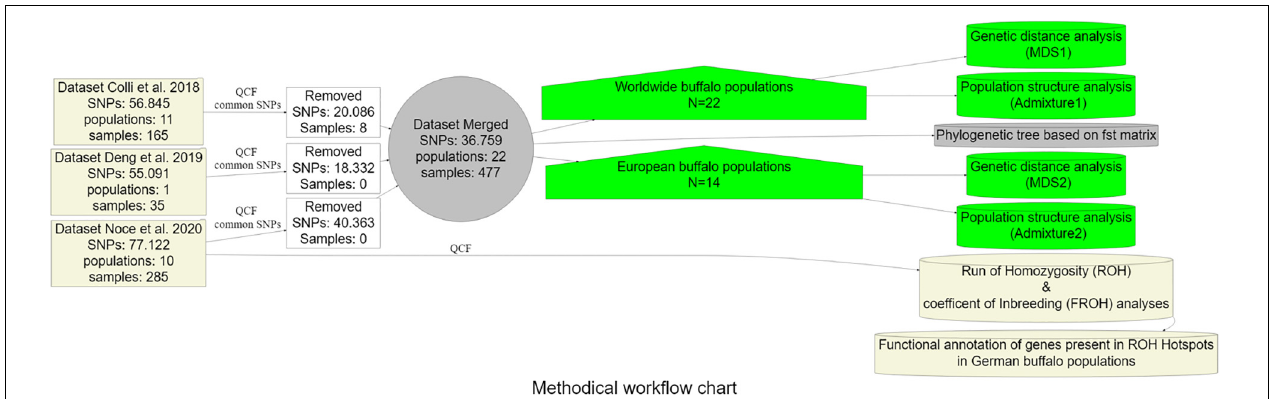
FIGURE 2 | Methodical workflow chart summarizing the analysis pipeline followed in the current study. QCF = Quality control filters (MAF < 0.05, -geno 0.01, -mind 0.01).